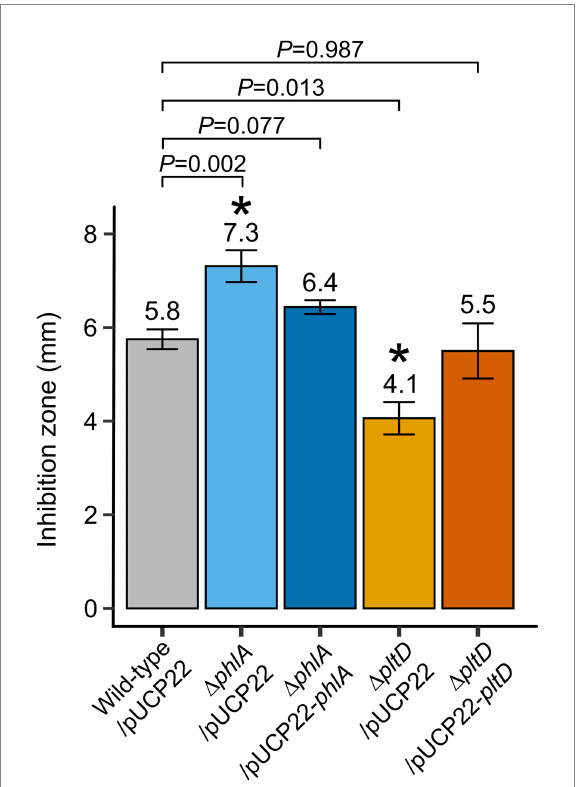
FIGURE 2 In vitro confrontation assays of Pseudomonas protegens Pf-5- derived strains against Botrytis cinerea mycelium growth. Potato dextrose agar plates containing plugs of B. cinerea mycelium and drops of normalized bacterial suspensions (10 8 CFU ml − 1 in PBS solution) were incubated at 25 ° C in the dark. Inhibition zones between the bacterial colonies and mycelium growth were measured after 5 days. Means (indicated above each bar) and standard errors are from two independent experiments containing four replicates each ( n = 8). Exact p values are indicated for comparisons with wild-type/pUCP22 according to Fisher’s LSD post-hoc analysis with Benjamini-Hochberg correction, * represents p <